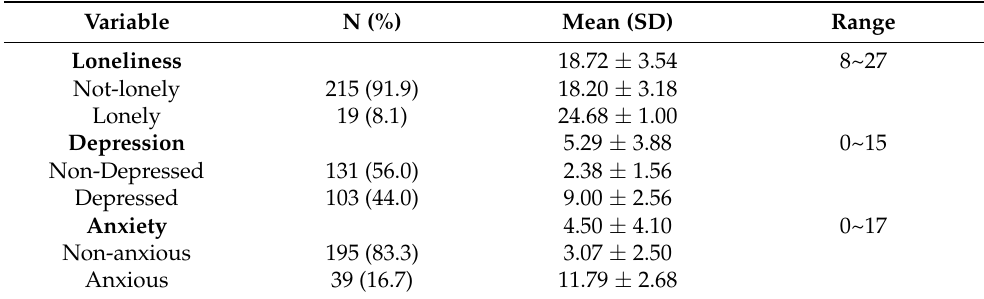
Table 2. Descriptive statistics of widow’s loneliness, depression, and anxiety (N = 234, % or mean ± SD).